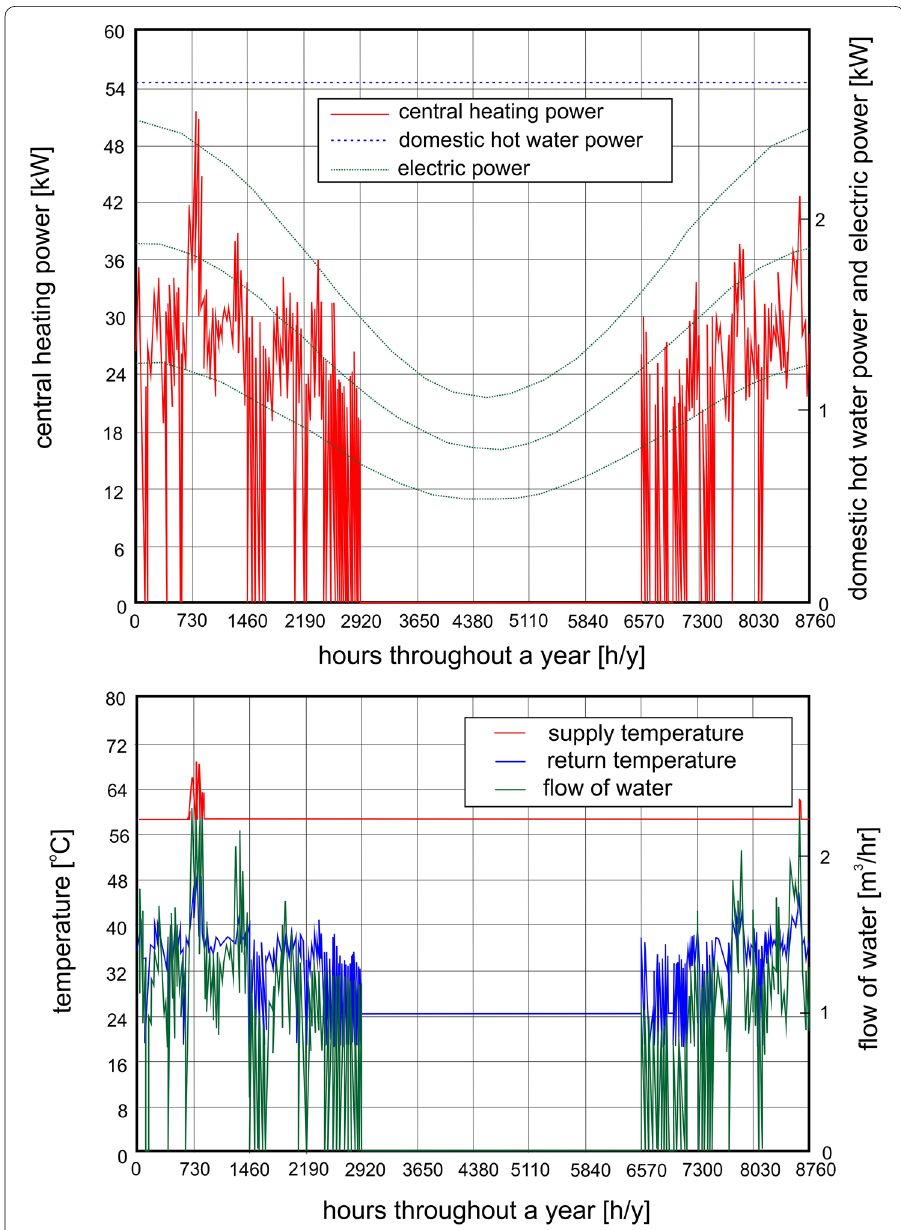
Fig. 14 Dynamic characteristics of the thermal and electrical power demand and the flow rate, supply and return temperature for the small greenhouse. P ch Q el 11.6 MWh/y ( P ch —power demand–central heating, P dw —power demand–domestic hot water, P el — = electric power demand, Q ch —central heat use, Q dw —domestic hot water use, Q el —electricity